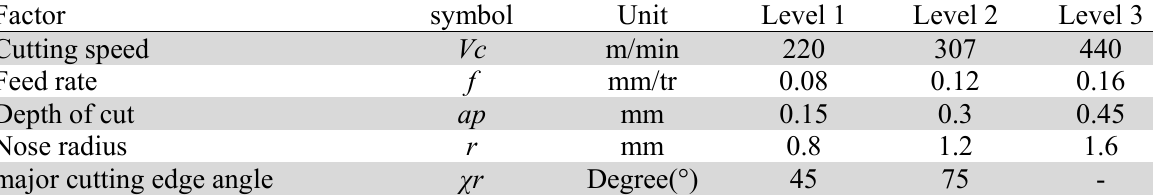
Process parameters and their